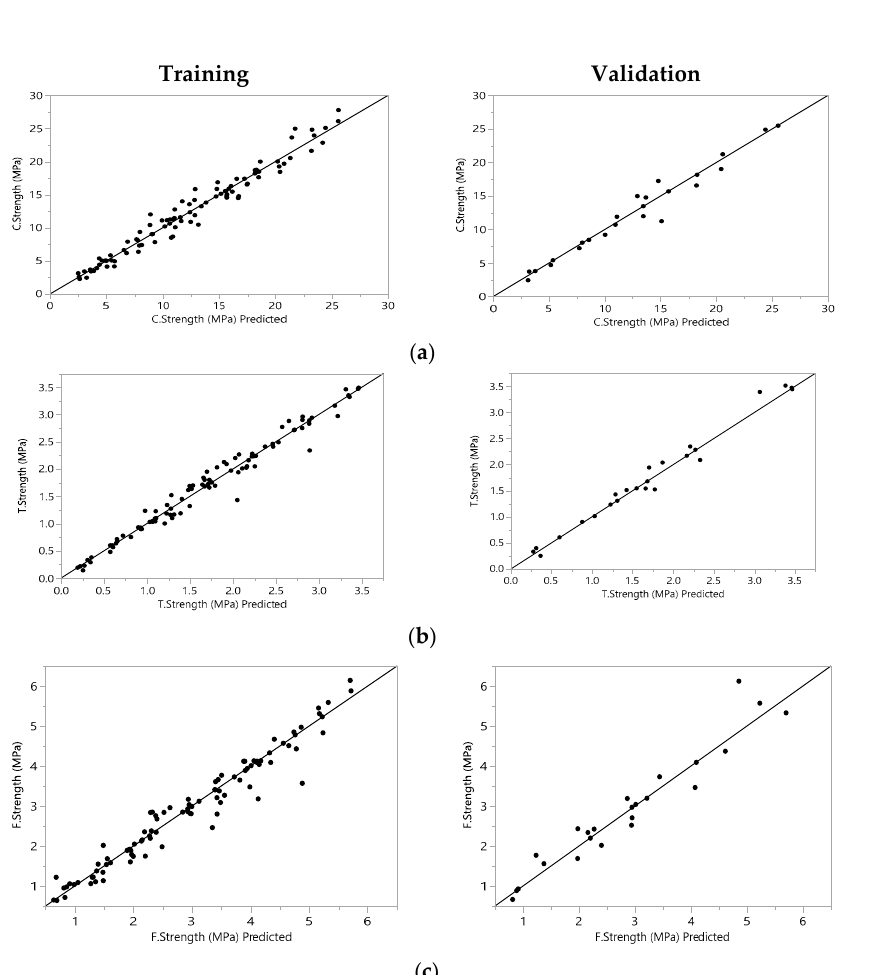
Figure 9. Training and validation plots for ( a ) compressive strength, ( b ) tensile strength, ( c ) flex- ural